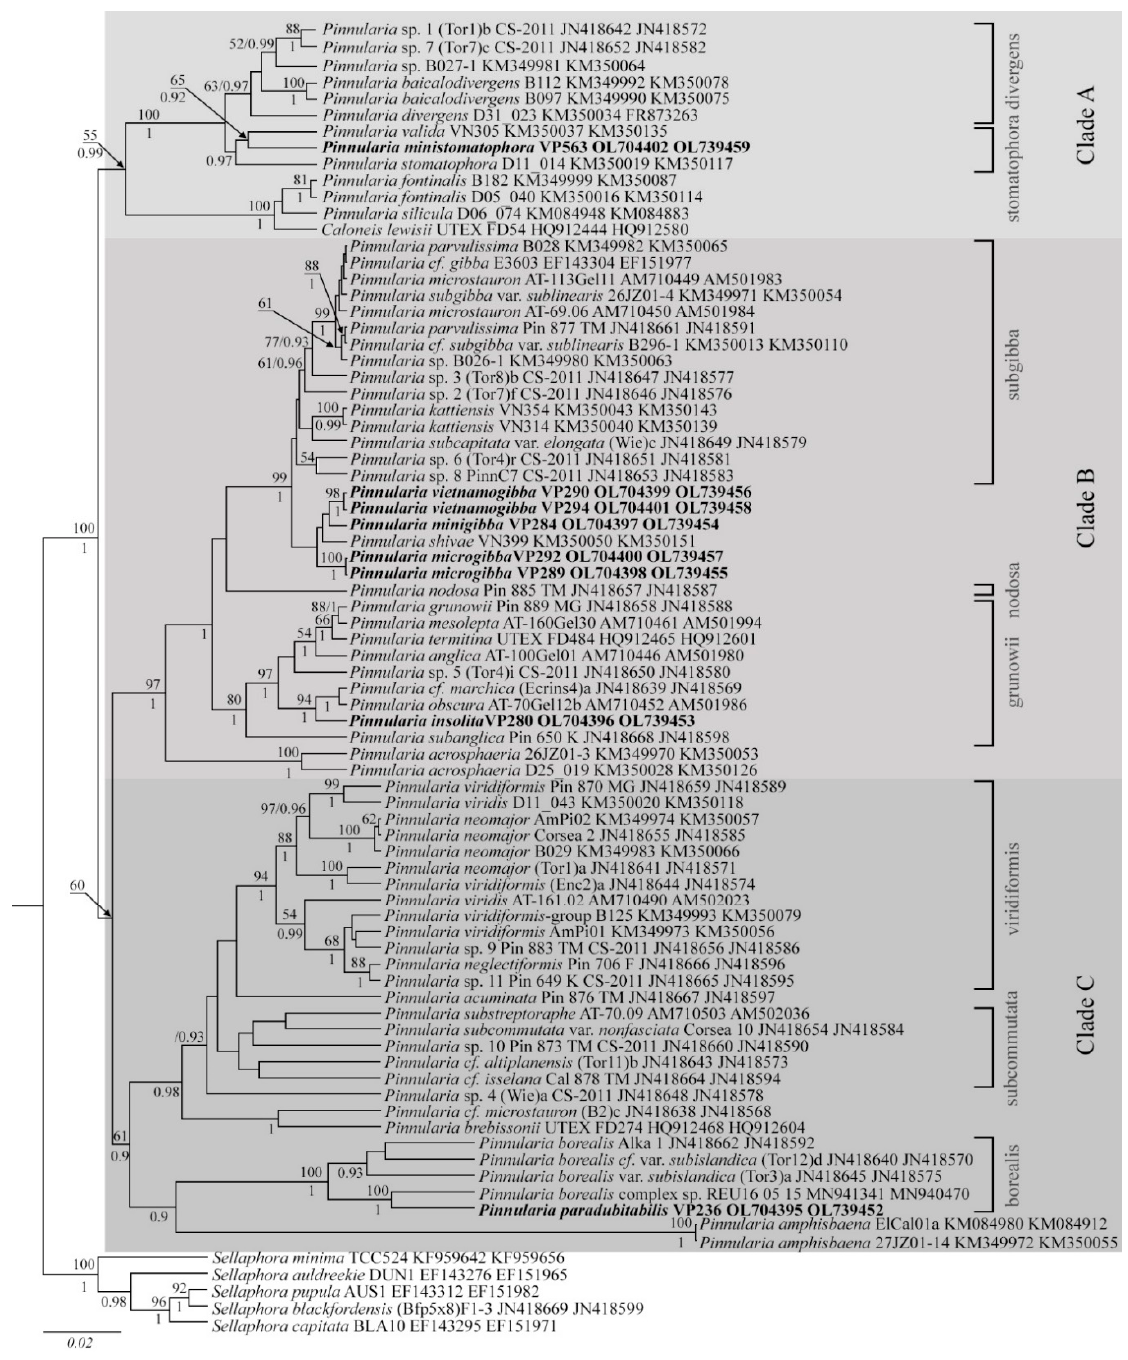
Figure 2. Phylogenetic position of the new Pinnularia species (indicated in bold) based on Bayesian inference for the partial 18S rDNA and rbc L genes. The total length of the alignment is 1407 characters. Bootstrap supports from ML (constructed by RAxML) and posterior probabilities from BI (constructed by Beast) are presented on the nodes in order. Only BS and PP above 50 and 0.9 are shown. Strain numbers (if available) and GenBank numbers are indicated for all